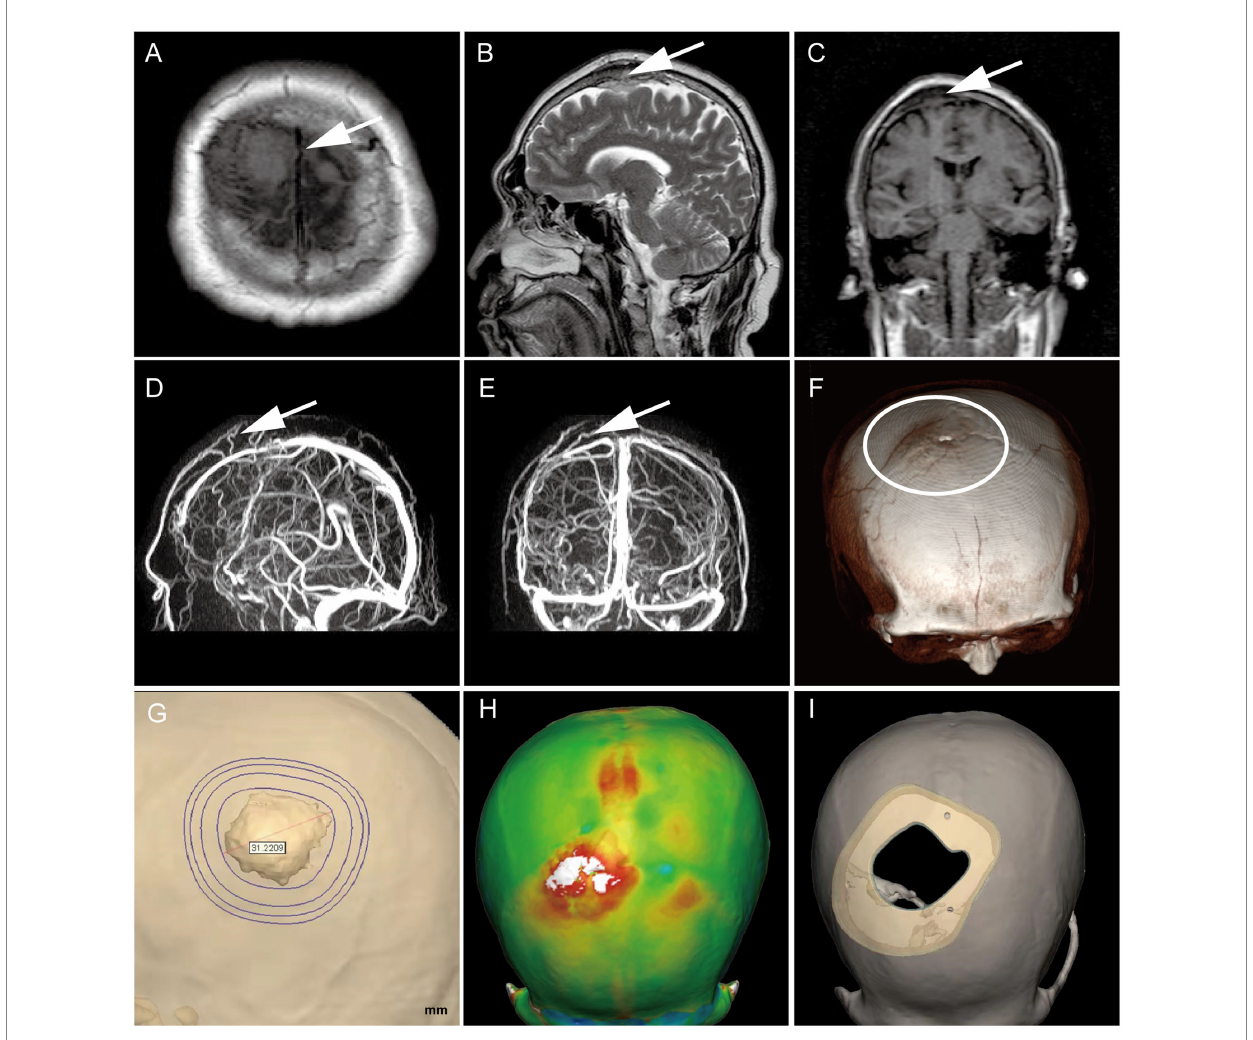
FIGURE 1 Preoperative MRI confirmed the tumor’s location (white arrow), with T1 low signal and T2 equal high signal, invading the skull and compressing brain tissue locally (A–C) .MRV suggests that it is closely related to the branches of the sagittal sinus (D,E) ; Preoperative CT three-dimensional reconstruction showed a slight skull bulge at the lesion site (F) ; Determine the skull repair scheme by three-dimensional modeling (G–I)